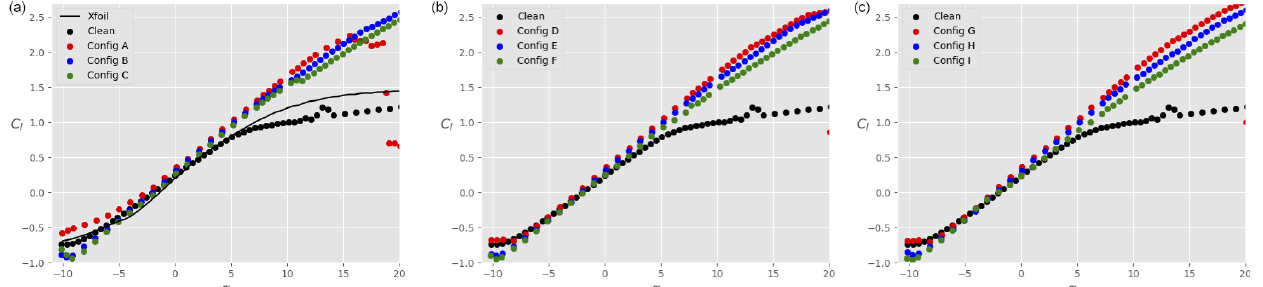
Figure 5. Total lift coefficient C l on the ensemble airfoil + slat as a function of the angle of attack α for different slat configurations, a clean main airfoil (i.e. no tripping), and Re = 1 . 5 × 10 6 : h slat /c main = 0 . 02 (a) , h slat /c main = 0 . 03 (b) , and h slat /c main = 0 . 04 (c) . The black data are taken without slat, while the coloured data are in the presence of a slat with β slat = 16 . 4 ◦ (red), β slat = 21 . 4 ◦ (blue), and β slat = 26 . 4 ◦ (green). The results of Xfoil simulations for the clean main airfoil are shown by the continuous black line (a) .